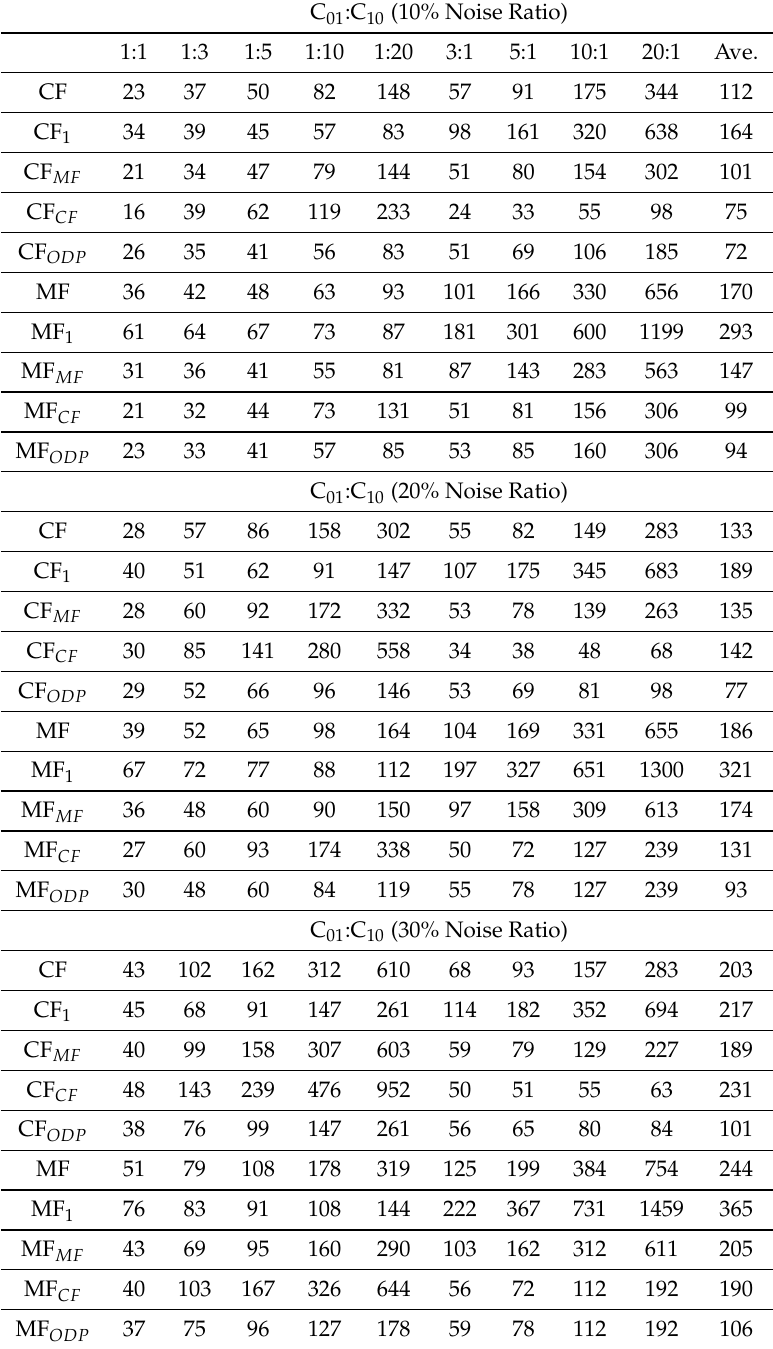
Cost comparisons on Heart in the case that the noise ratio and noise-free dataset are